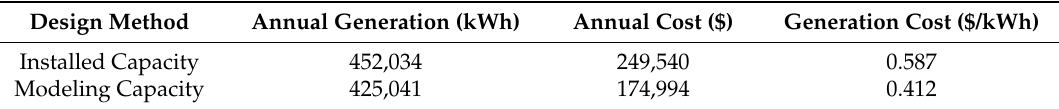
Table 11. Economic comparison of operation costs by estimated load pattern for Island 7.